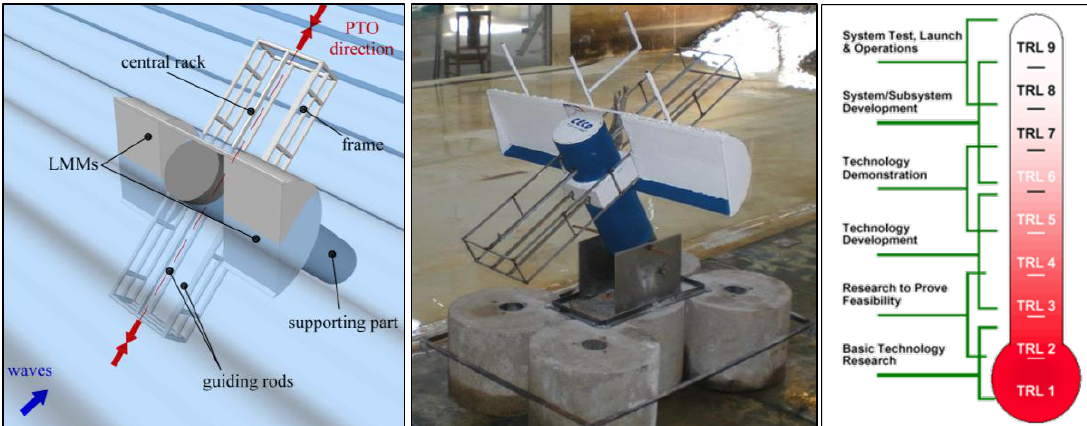
Figure 1. A sketch concept of the latest CECO version ( left ), the physical model of CECO during the experimental proof of concept ( middle ) and the Technology Readiness Level (TRL) scale ( right